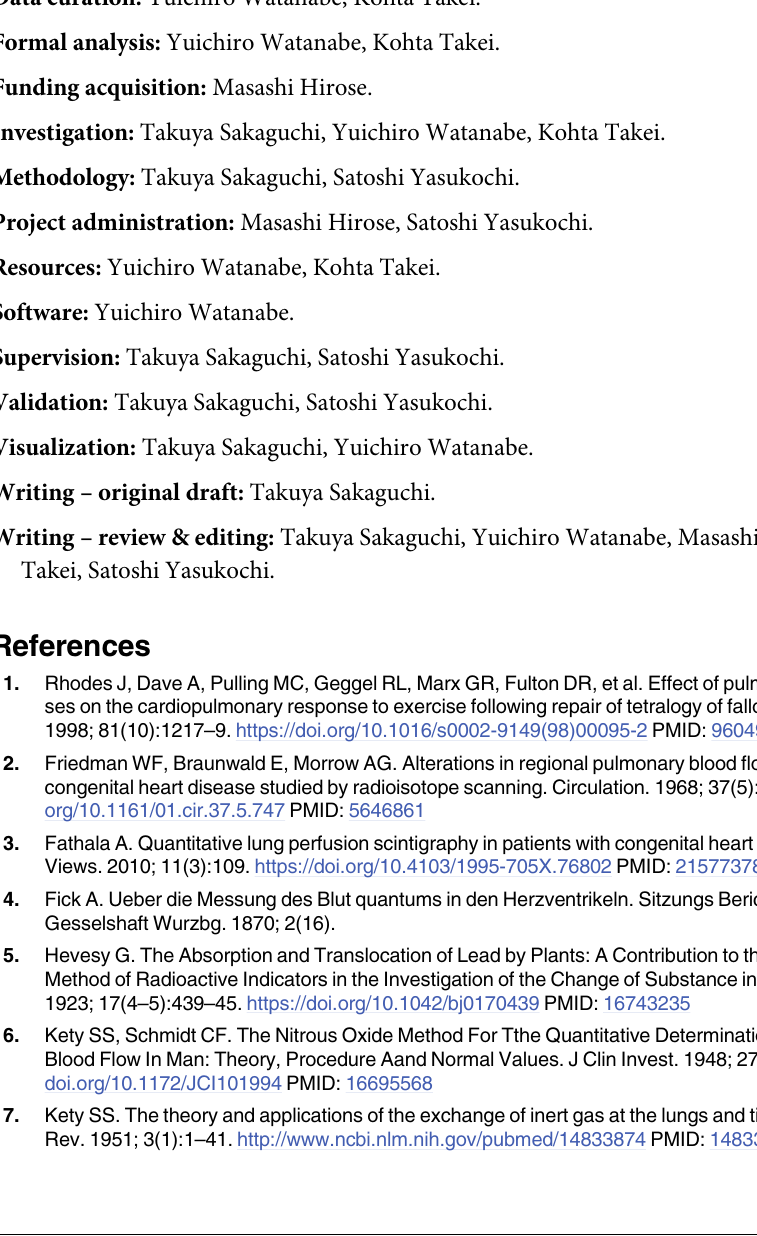
S1 Table. Time signal intensity